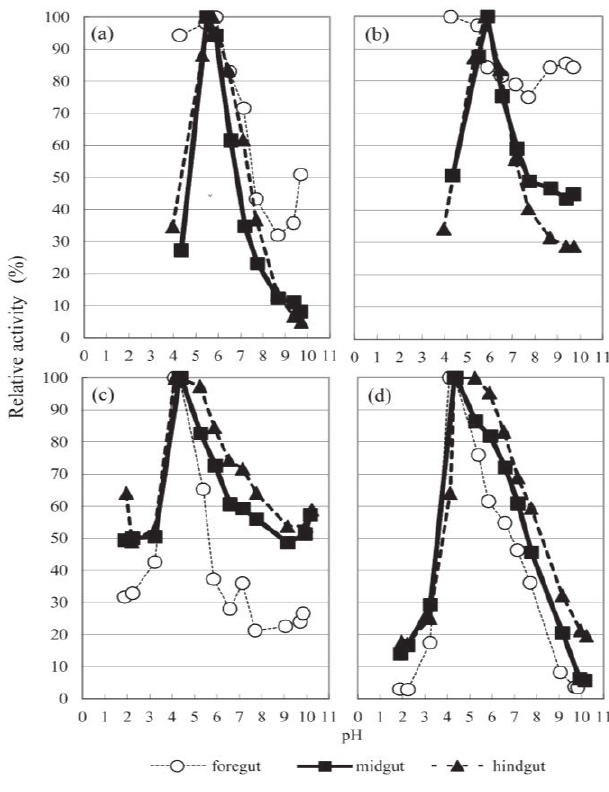
Figure 3. The pH profile of glycosidases from the digestive tract of T. dichotomus